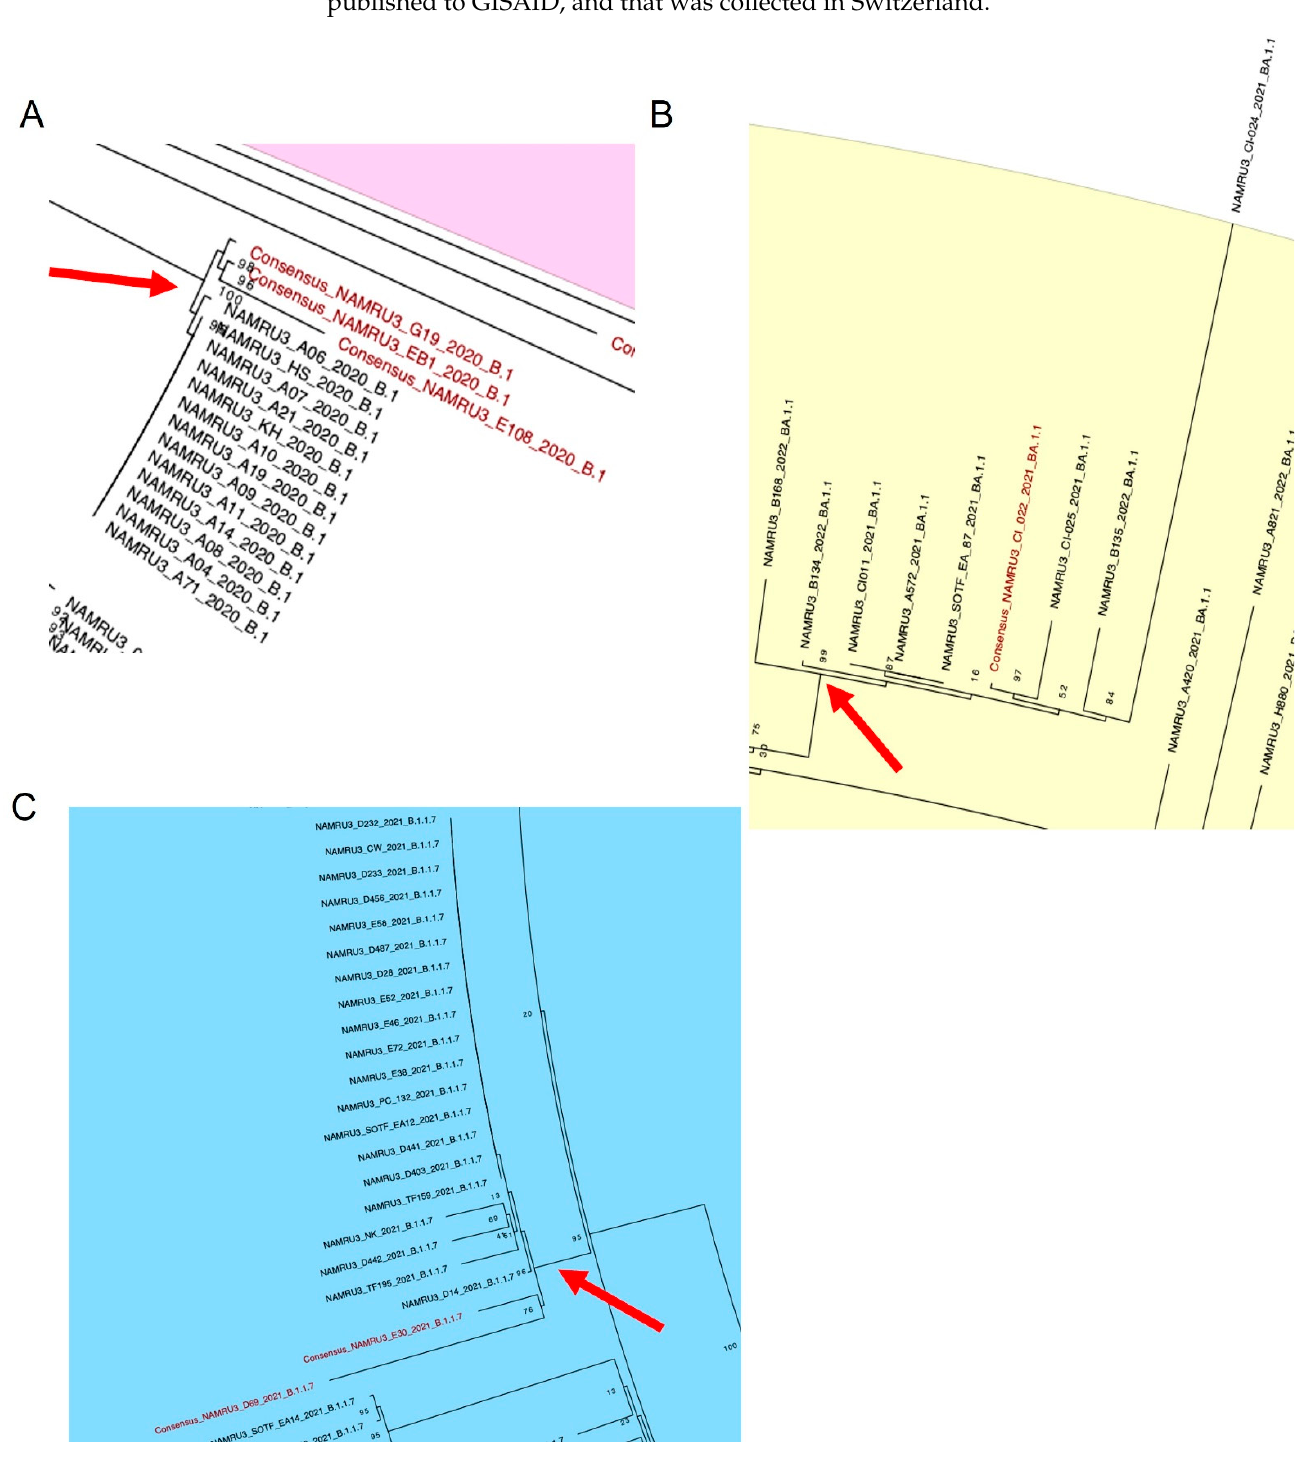
Figure 4. Close-up of phylogenetic clusters of samples with rare spike mutations from Figure 2: ( A ) 16 samples of lineage B.1 with spike mutation S494P; ( B ) 9 samples of lineage BA.1.1 with spike mutation S494P; ( C ) 22 samples of B.1.1.7 with spike mutation H49Y. The coding-complete genomes are shown in black, while the non-coding-complete consensus genomes are shown in red. Nodes are labeled with bootstraps.